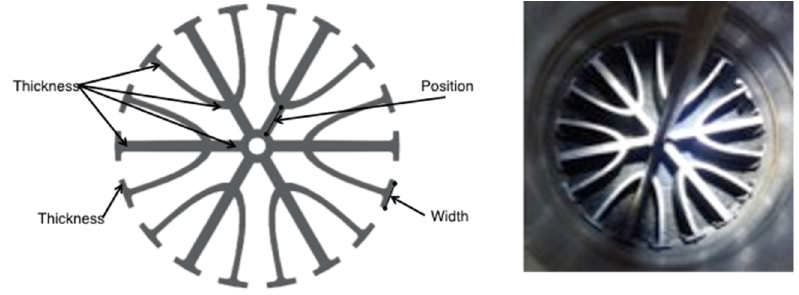
Figure 2. Schematic and picture of internal cooling fin.